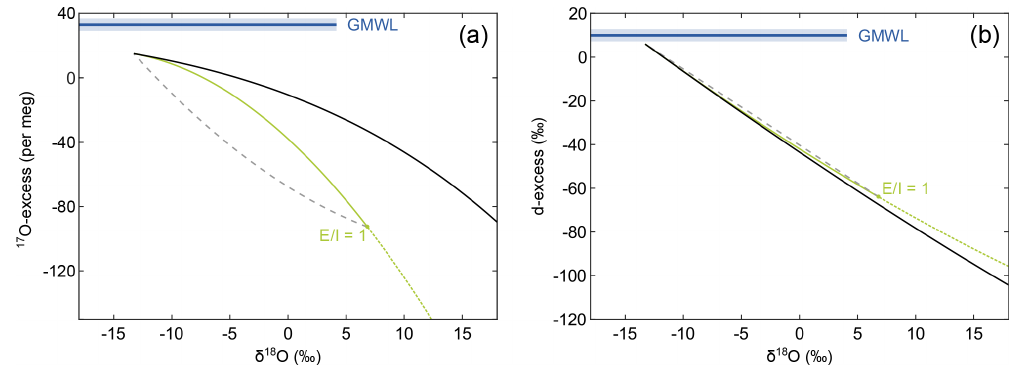
Figure 3. Conceptual comparison of isotope effects associated with the three principal hydrological processes – simple evaporation without recharge, evaporation with recharge, and isotopic mixing – in the diagram of (a) 17 O-excess over δ 18 O and (b) d-excess over δ 18 O. In the case of simple evaporation, the isotopic composition of an evaporating water body evolves along the black line. Continuous recharge drives the isotopic composition of the evaporating water body below the simple evaporation trajectory onto the green line. The isotopic composition of a recharged lake is determined by the evaporation-to-inflow (E / I) ratio, where increasing E / I leads to higher δ 18 O and lower 17 O-excess values. In the case of a terminal lake (E / I = 1) all inflow is balanced by evaporation. The dashed grey line exemplifies admixture of fresh water similar in isotopic composition to the inflowing water, e.g. flood water, to the evaporated brine of a terminal